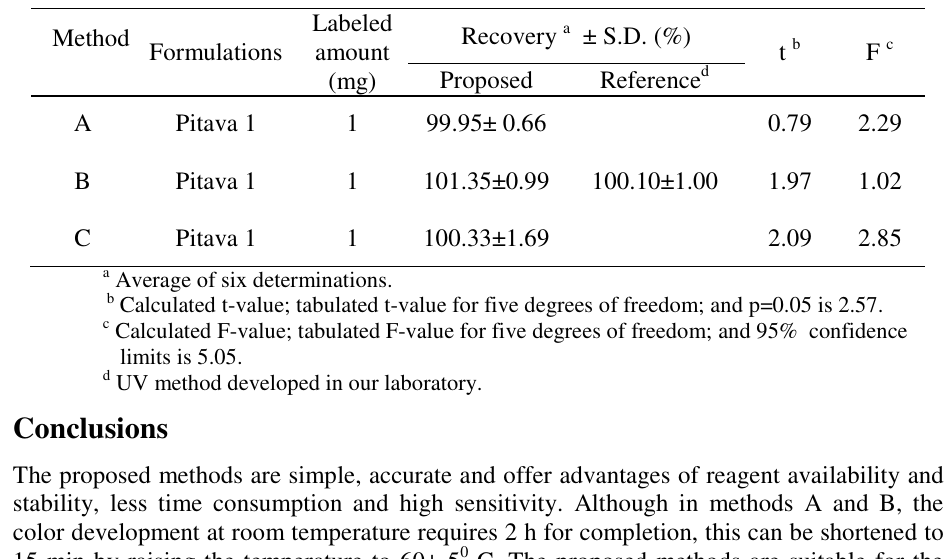
Table 2. Results of analysis of tablet formulation containing